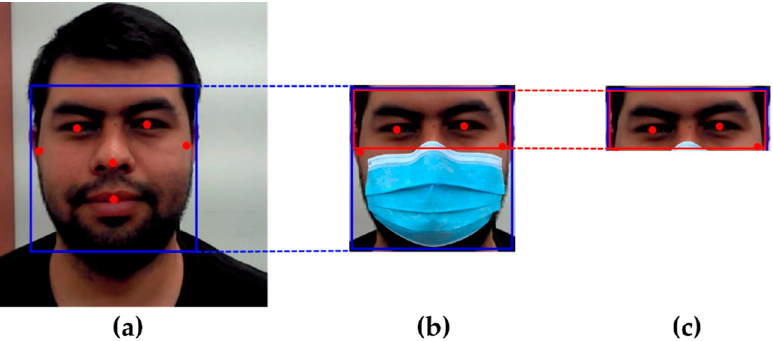
Figure 8. Generating and detecting synthetic masked face; ( a ) face regions detected using MediaPipe face detection; ( b ) the face is covered with synthetic facial mask using MaskTheFace; ( c ) detected upper features of the face.